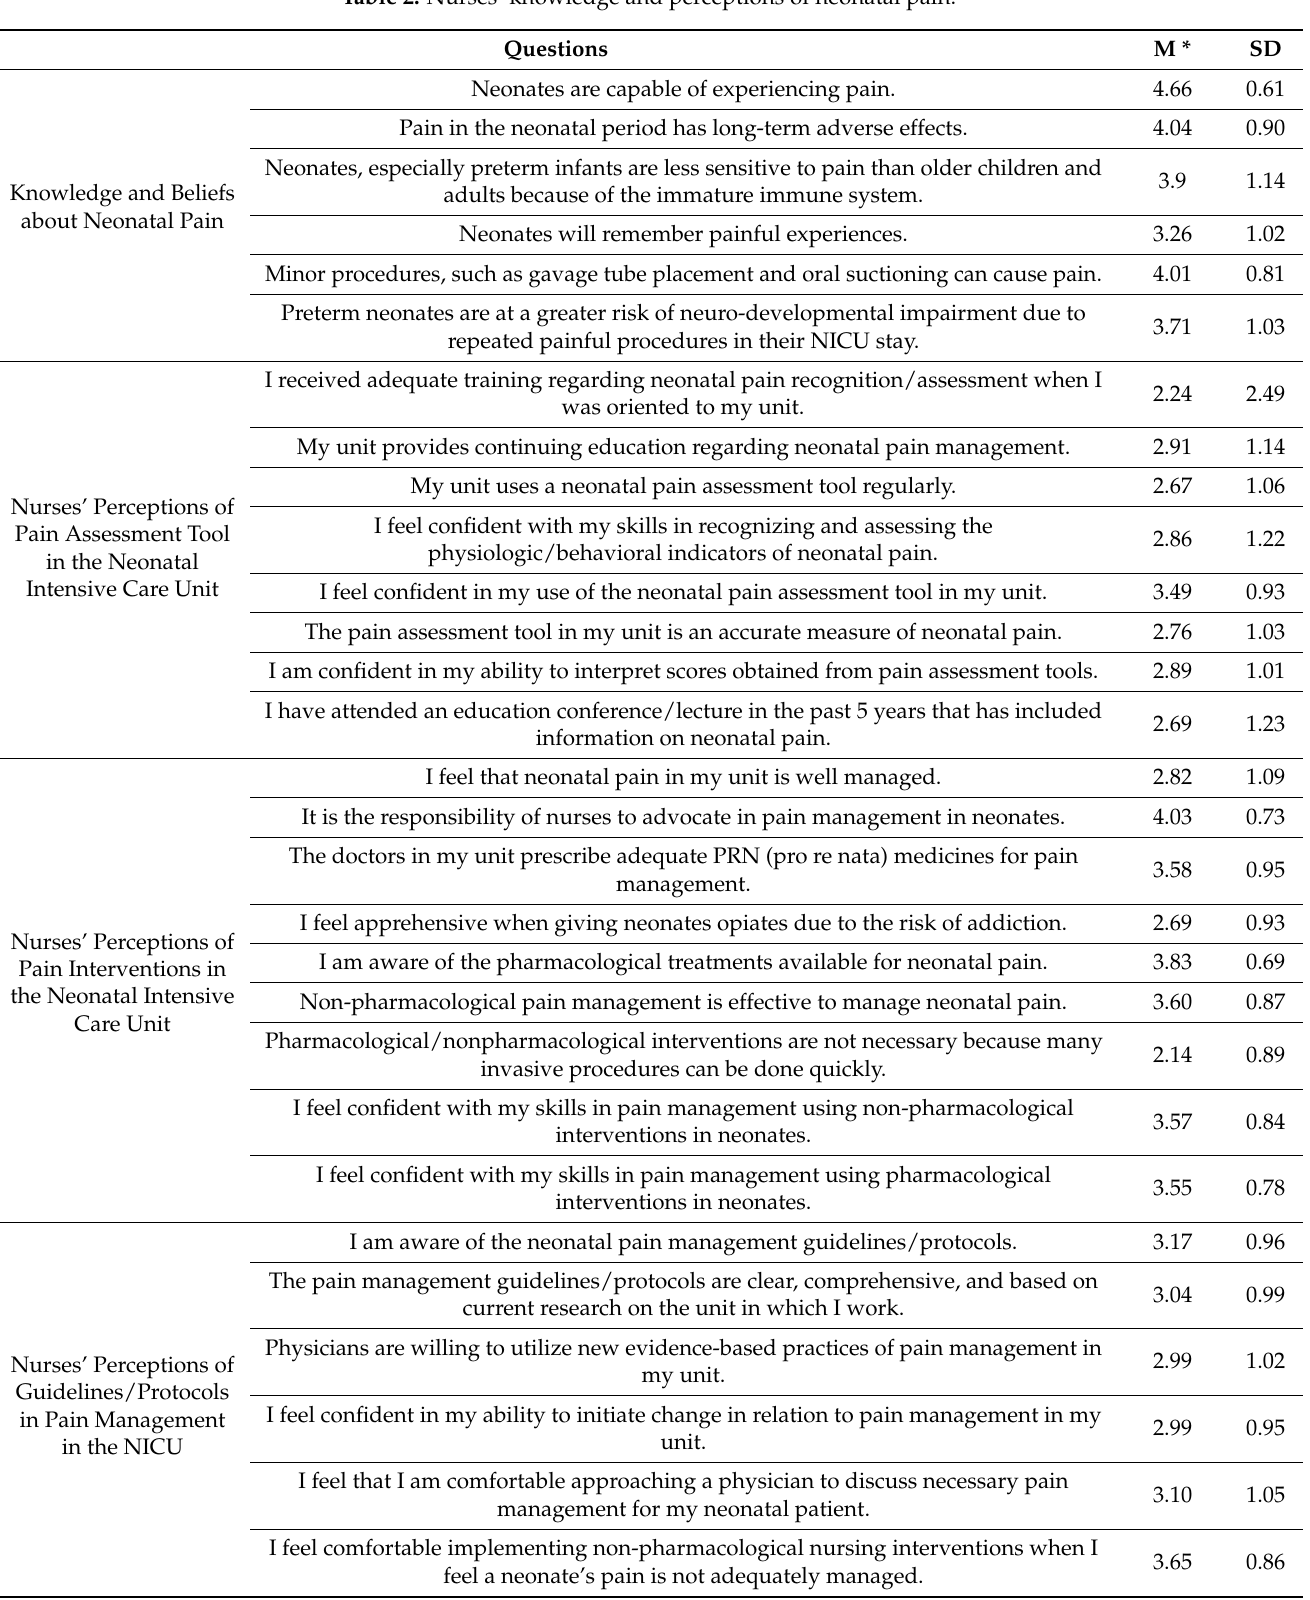
Table 2. Nurses’ knowledge and perceptions of neonatal